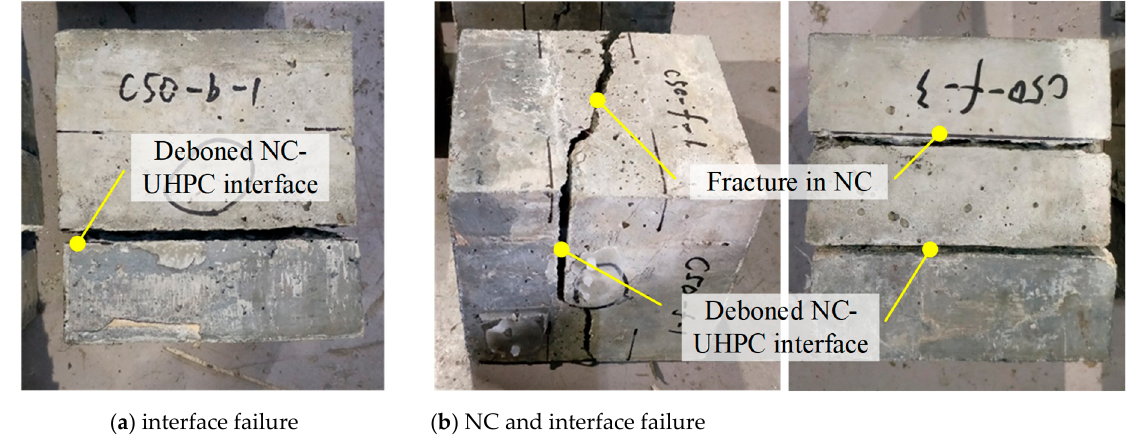
Figure 9. Failure modes of bi-shear tests. Table 4. Summary of the bi-shear test results.